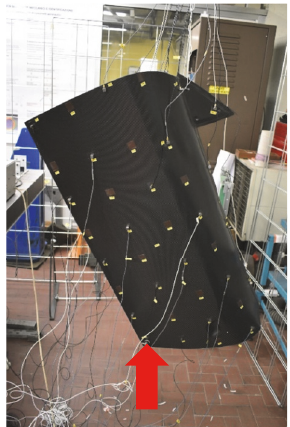
Figure 9: The door panel: experimental configuration with 23 accel- erometers, a load cell (red arrow), and 44 measurement points.